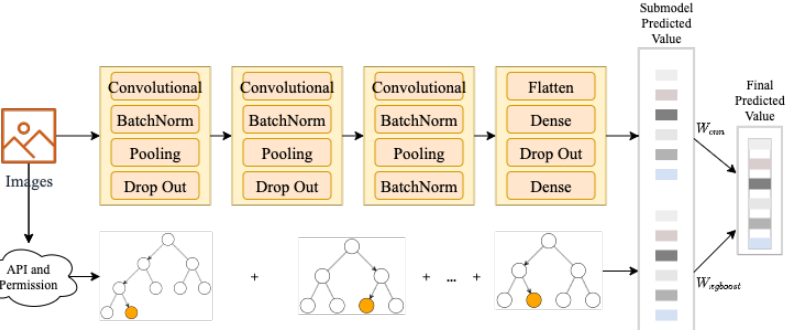
Figure 11. Convolutional Neural Network and eXtreme Gradient Boosting (CNNXGB) classification model.